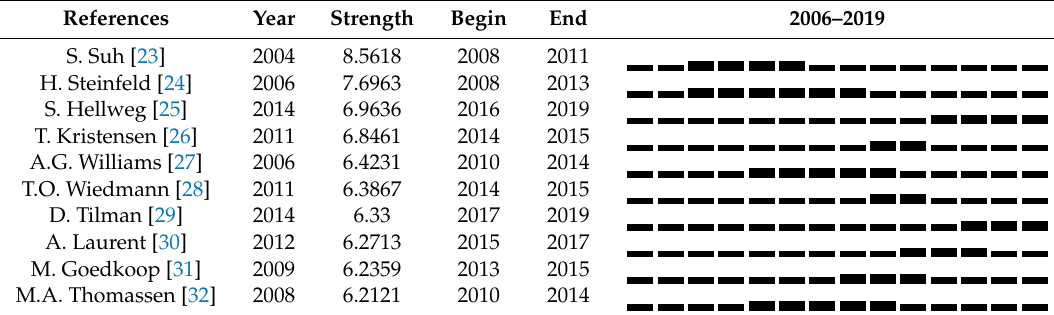
Table 10. Top 10 references based on citation burst strength.